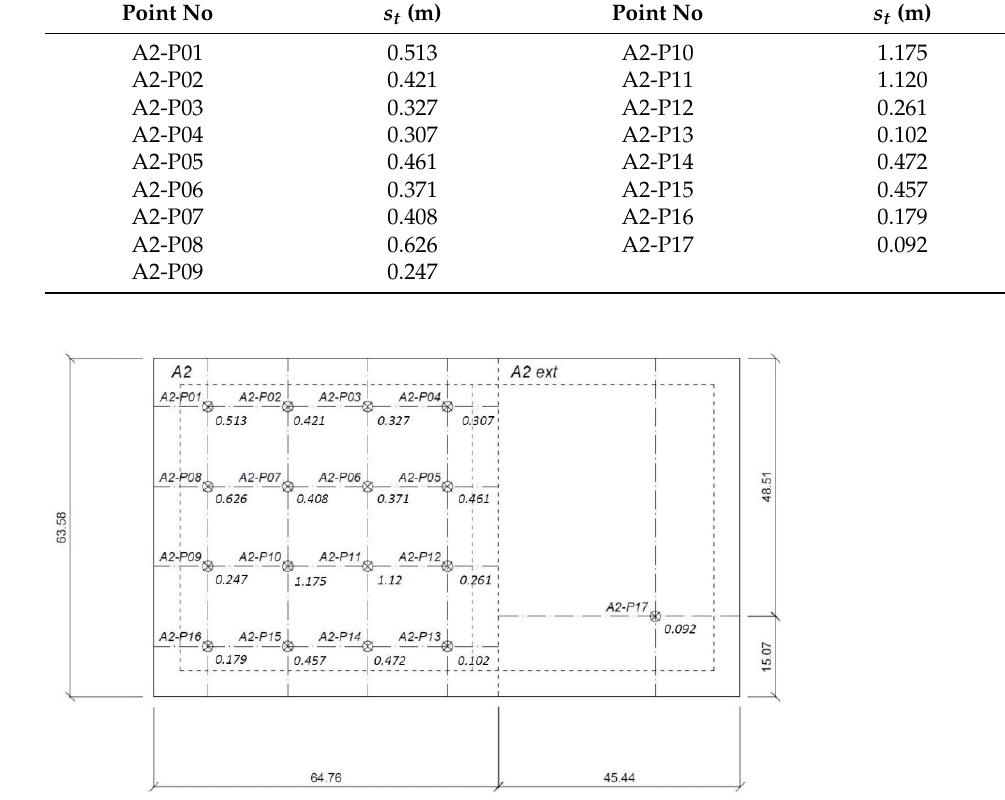
Table 5. Input parameters for determining the constrained modulus of elasticity of peat material by loading it with an embankment.